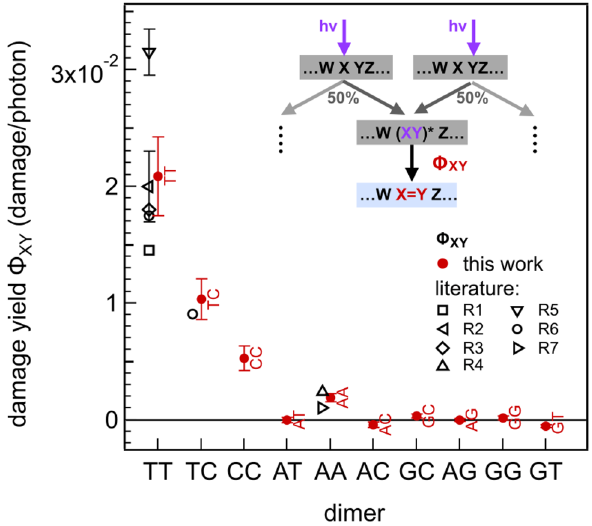
Figure 5. Quantum yields for the damage determined according to the molecular model with dimeric damage processes (see insert and Eqation 1). The quantum yields (red dots) agree well with the literature (black, open symbols) for the bi-pyrimidines: R1: 2 , R2: 4 , R3: 12 , R4: 36 , R5: 37 , R6: 25 , R7: 33 . For most purine containing